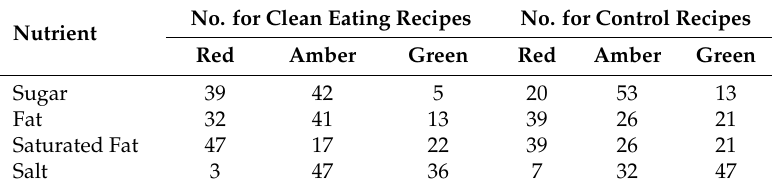
Table 4. Number of recipes that met the U.K. Food Standards Agency (FSA) nutrient profiling criteria.